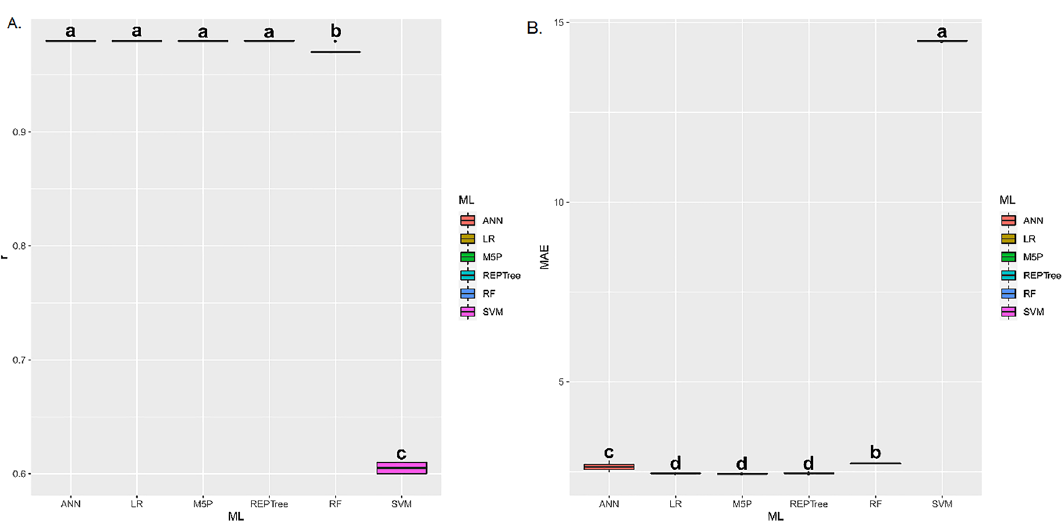
Figure 10. ( A ) Boxplot for Pearson correlation coefficient (r), and ( B ) mean absolute error (MAE) between observed and estimated values of germination in corn grains by different machine learning models and inputs. Means followed by equal letters in the same column do not differ by the Scott–Knott test at 5%